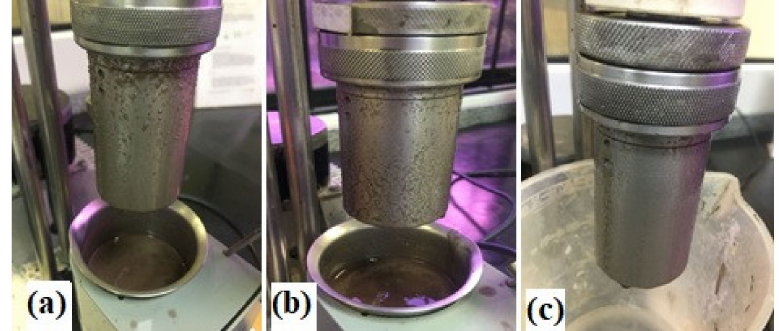
Figure 14. Compatibility of the cement slurry with ( a ) system 1, ( b ) system 2, and ( c ) system